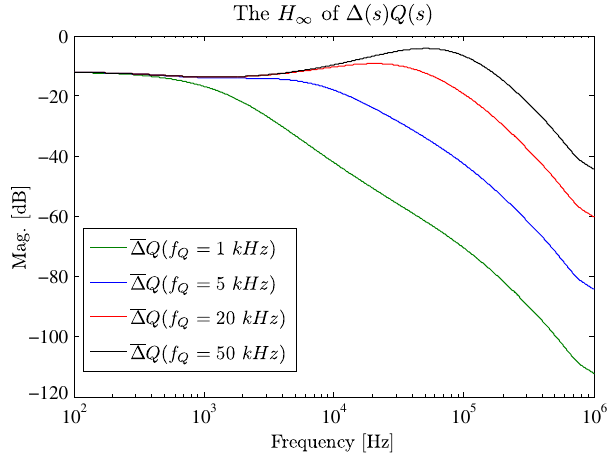
FIG. 14. The H ∞ norm of Δ ð s Þ Q ð s Þ . Assuming the detuning is 50 Hz and the phase calibration error is 10 degrees in the system. In addition, there is no mismatch in G